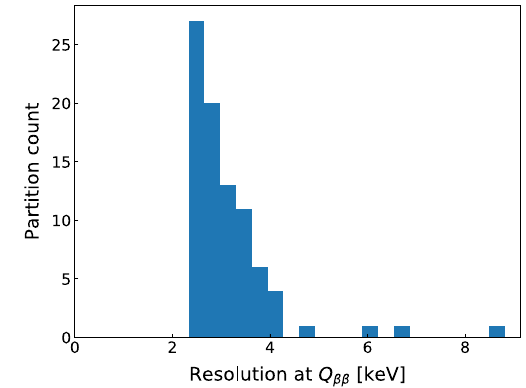
Fig. 3 FWHM of the FEP as a function of time for detector GD76B, one of the BEGe detectors. Each data point comes from one calibra- tion run. The full data acquisition period is divided into three partitions, showninsolidcircle(blue),triangle(green),anddiamond(red),respec- tively. The time of the 2018 upgrade is represented by the dashed line. A second partition (shown in triangles) began directly afterwards with a coincident improvement in resolution. A third partition (shown in dia- monds) was created due to the jump in resolution in January 2019 when a hardware change took place